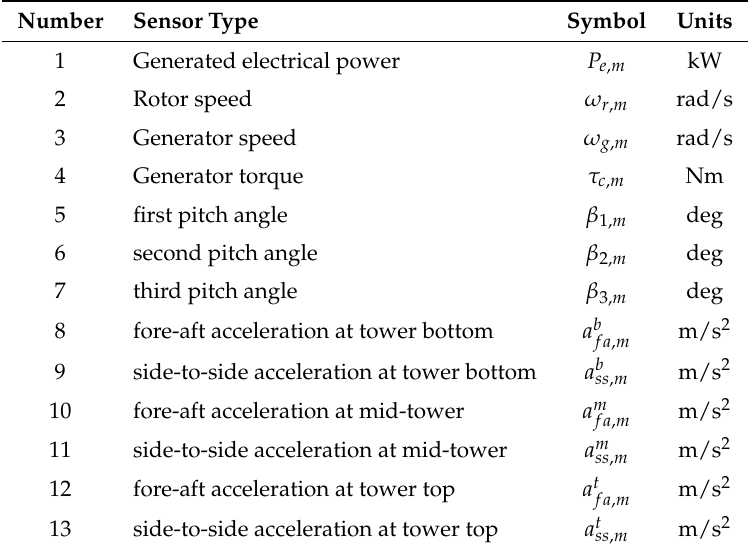
Table 2. Assumed available measurements. These sensors are representative of the types of sensors that are available on a MW-scale commercial wind